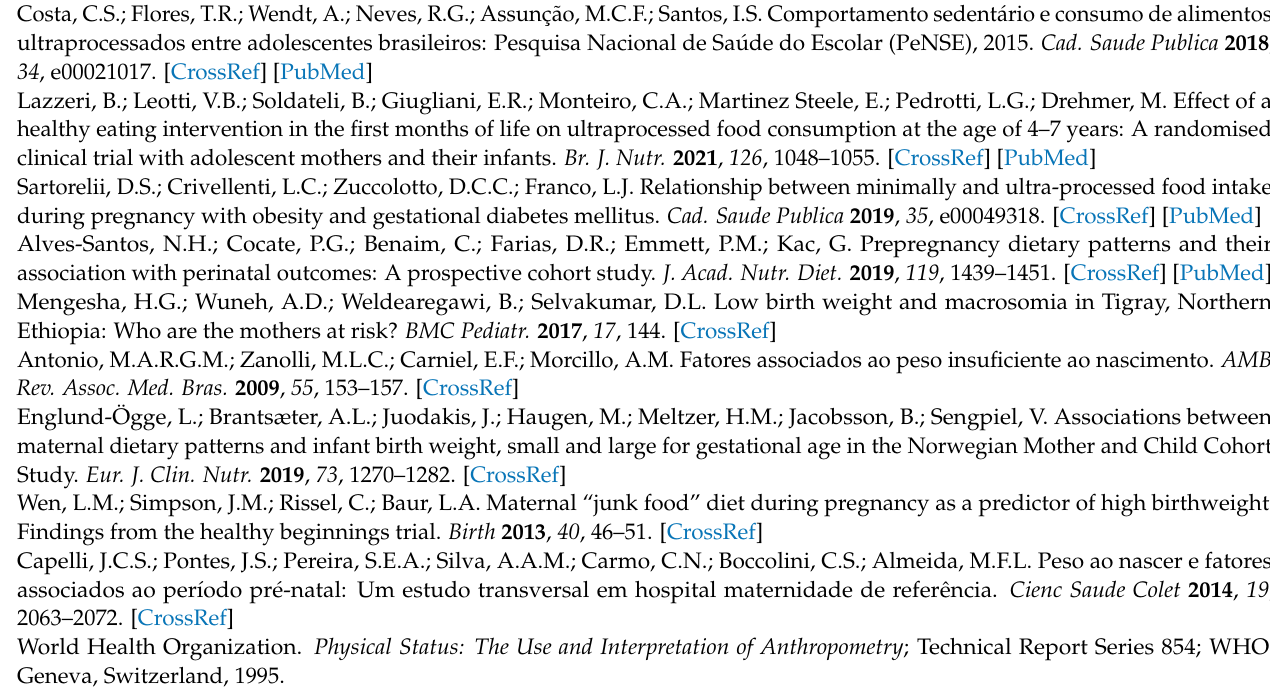
Table S1: Mean maternal energy percentual consumption by food processing groups during